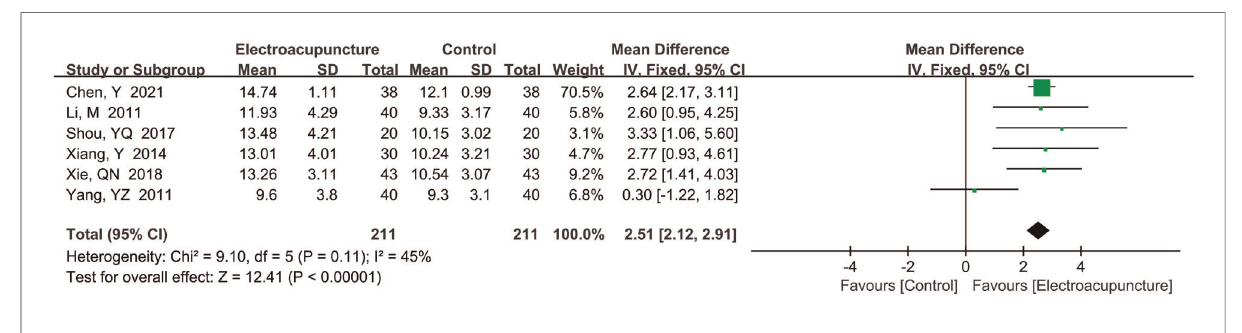
FIGURE 10 A forest plot showing the thumb-carpal